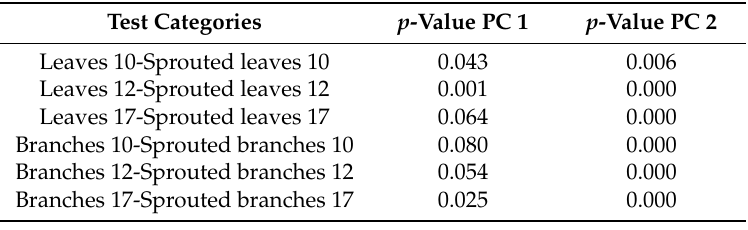
Table A2. Paired p values from mean tests for PC 1 and PC 2 scores resulting from principal component analysis for sequentially managed branch and leaf chemical attributes in each rosewood plantation located in the three study areas.